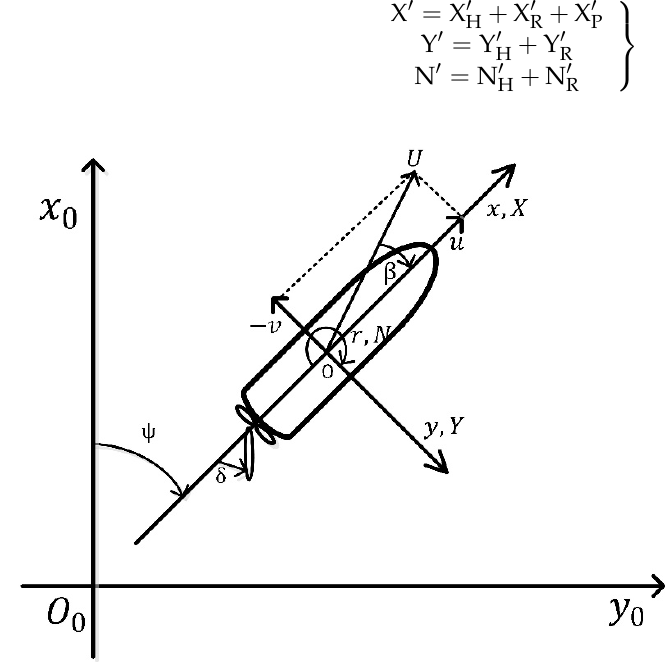
Figure 1. Coordinate